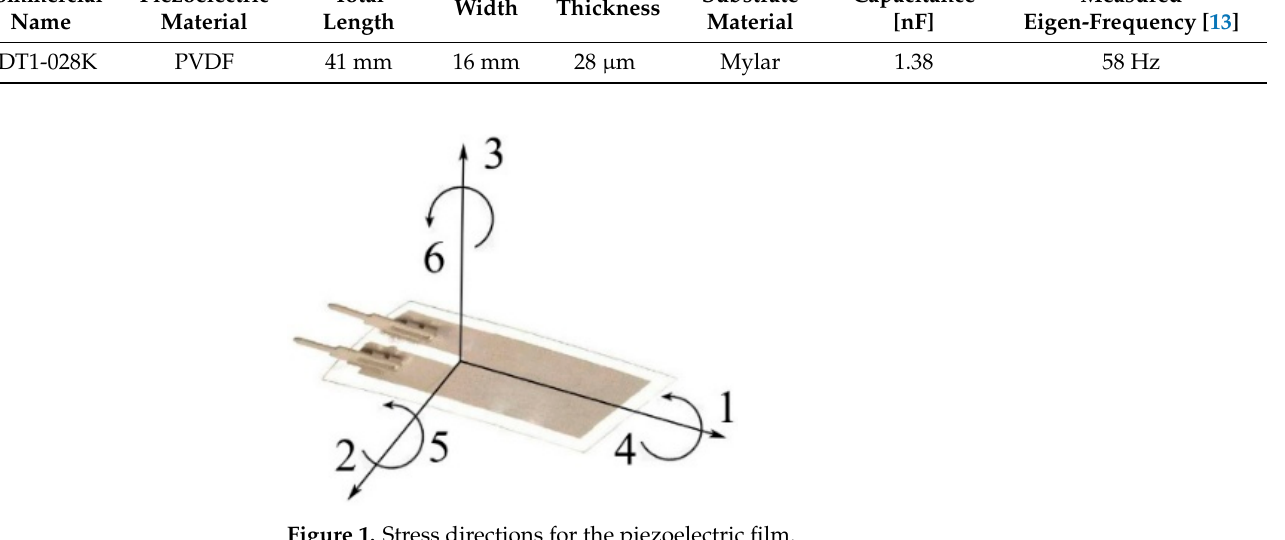
Table 1. LDT1-028K film characteristics [36]. Table 2. Piezoelectric charge coefficients for PVDF [37].